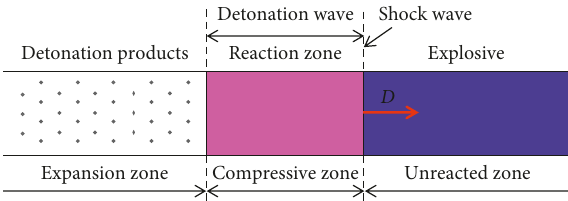
Figure 2: Illustration of the detonation of explosive and the propagation of the detonation